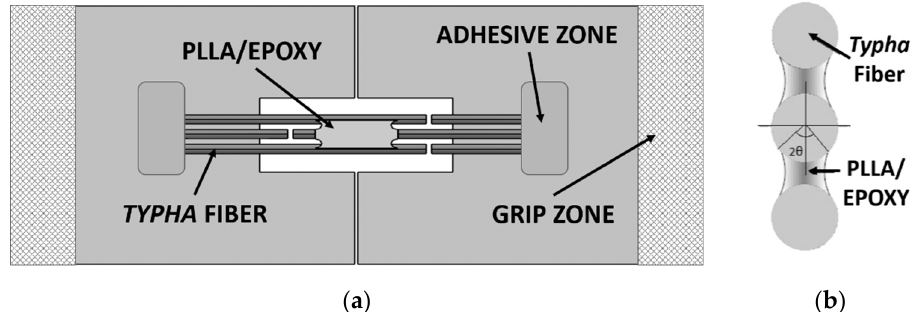
Figure 3. Schematics of the model composite. ( a ) Top view, ( b ) cross-section.